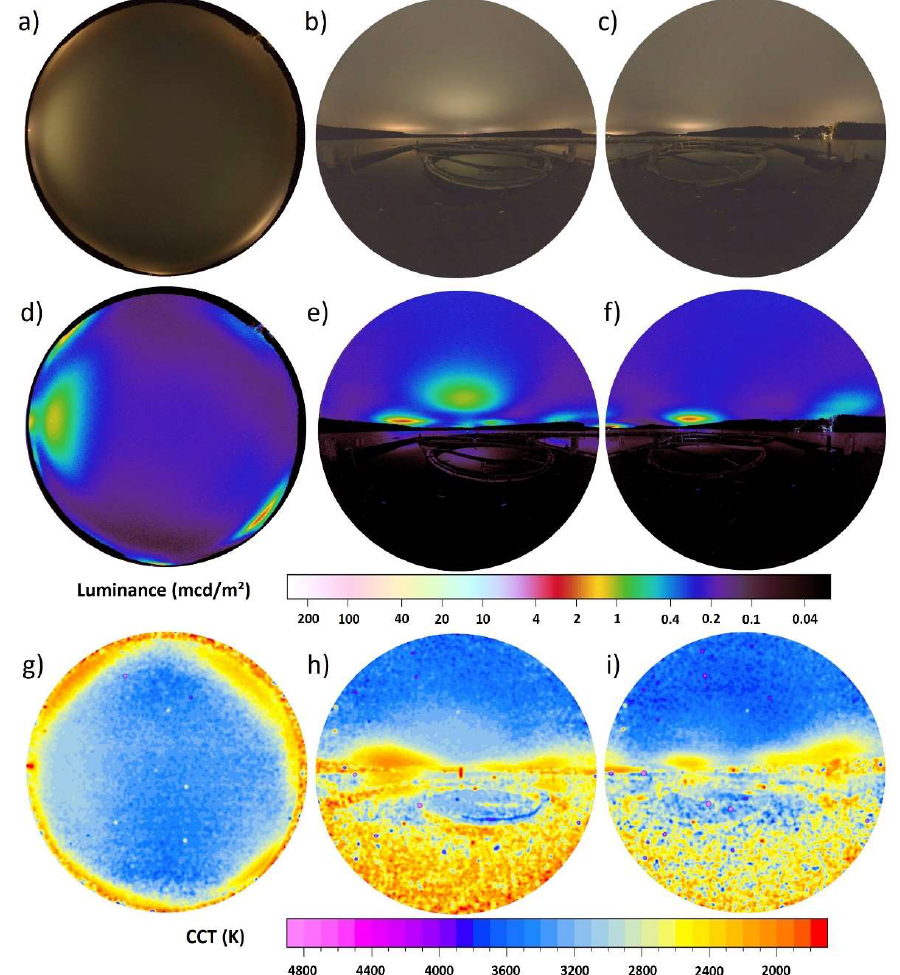
Figure 8. Imaging data taken during an overcast night in summer from a research platform in Lake Stechlin, Germany. The upper row ( a – c ) shows the RGB images, the center row ( d – f ) the calculated luminance maps and the lower row ( g – i ) the calculated CCT maps. The left column ( a , d , g ) shows the all-sky data the middle ( b , e , h ) and right ( c , f , i ) columns the vertical plane data.